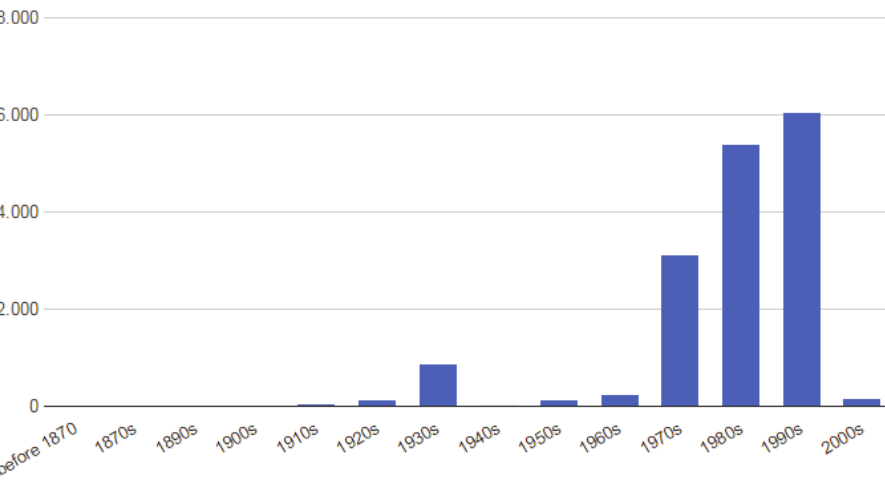
Figure 6. Temporal distribution of the